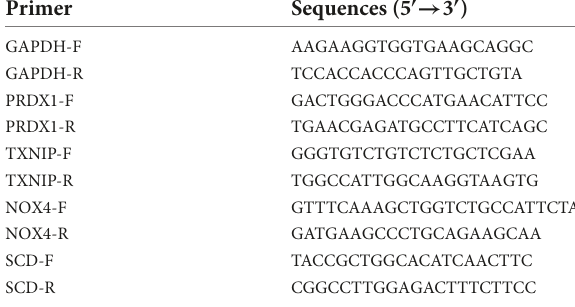
TABLE 1 Demographic and clinical characteristics of the included patients with abdominal aortic aneurysm and controls.